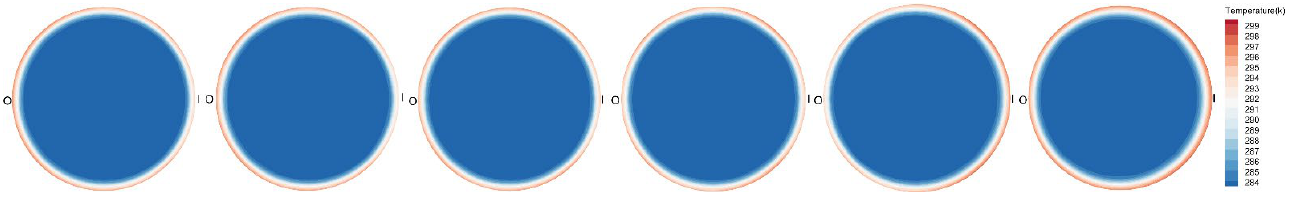
Figure 15. Temperature distributions on the five sections and the outlet plane of the U-shaped channel. From the left to the right, the order of these sections is from the inlet to the outlet of the channel. In this case, the inlet velocity is 0.5 m/s. The temperature boundary conditions are: 300 K on the wall and 283 K of the incoming fluid at the inlet.